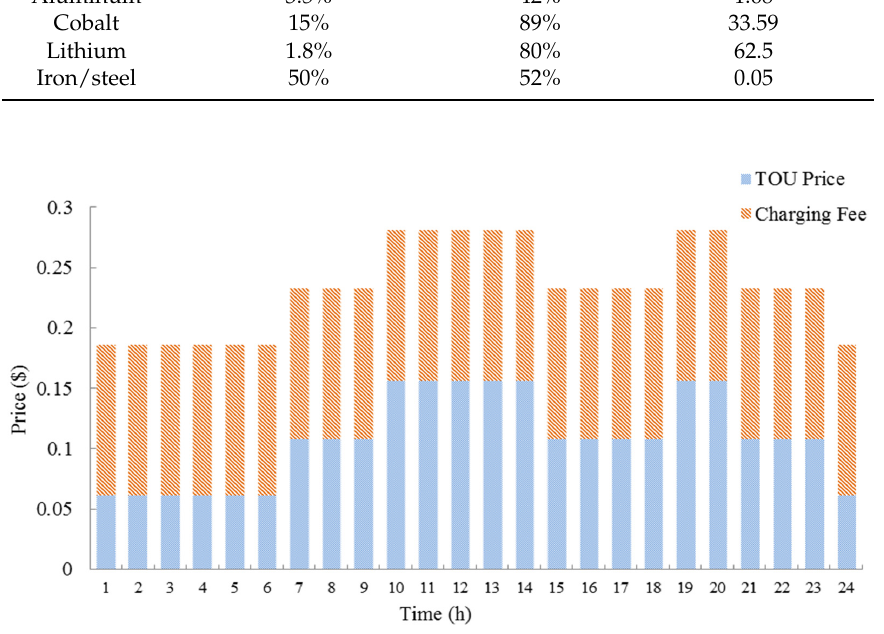
Figure 12. Time ‐ of ‐ use (TOU) electricity price and charging fee. Figure 12. Time-of-use (TOU) electricity price and charging